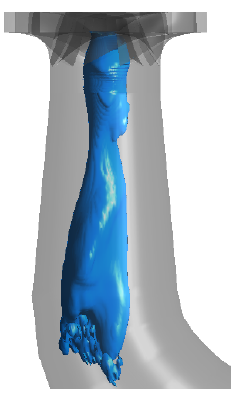
Figure 11. The cavitation area in the draft tube.